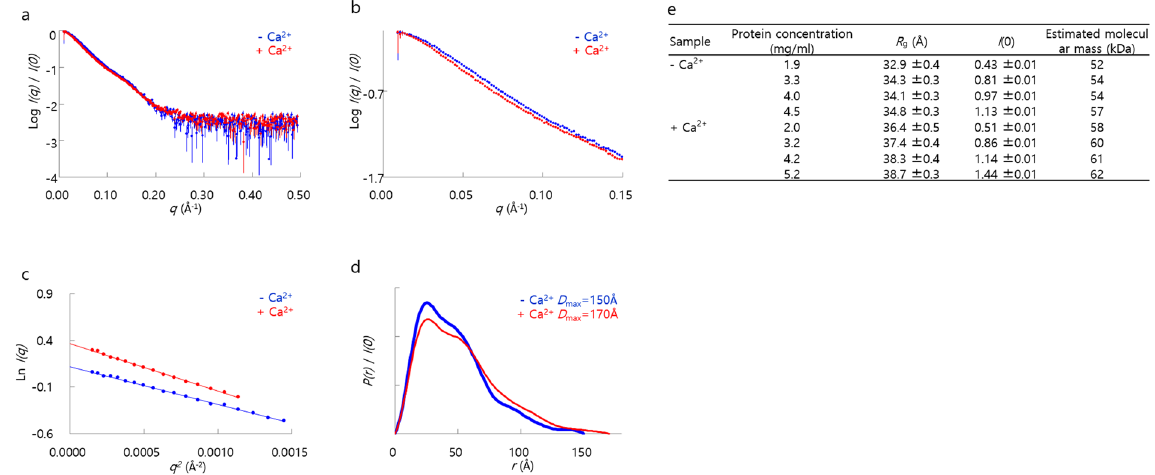
Figure 4. Small-angle X-ray scattering (SAXS) analysis of CsTAL3 induced by a Ca 2 + ion. (a , b) The experimental I ( q ) at the highest protein concentration and the close-up view of I ( q ). The experimental I ( q ) is shown as dots with error bars. (c) The Guinier plot at the highest protein concentration. (d) The distance distribution function P ( r ) at the highest protein concentration. (e) A summary of R g , I (0), and molecular mass estimated from the Guinier